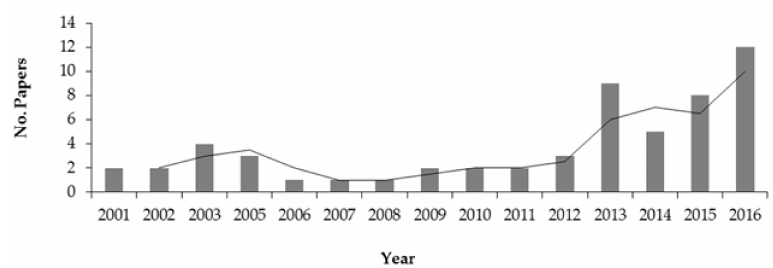
Figure 6. Dendrochronological studies realized in Mexico, grouped by year of publication.